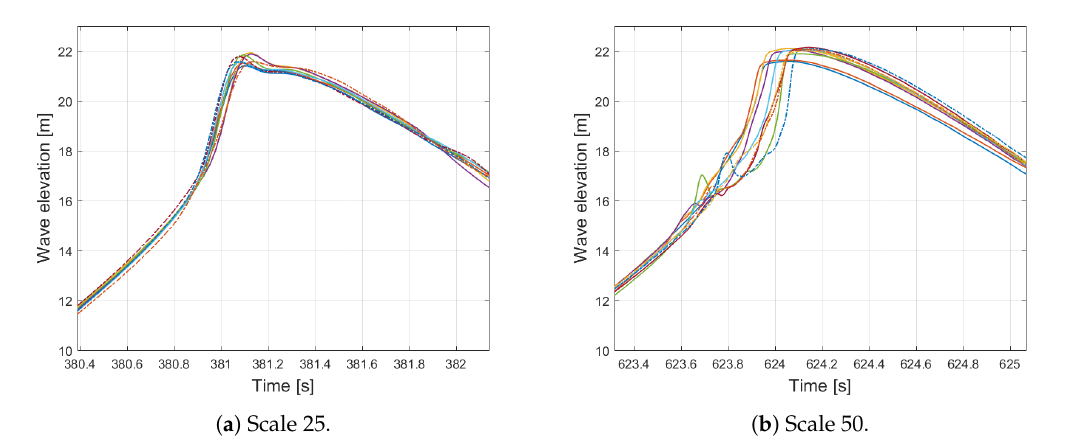
Figure 21. Repeatability of focused Wave 1 at two scales—both in atmospheric conditions.